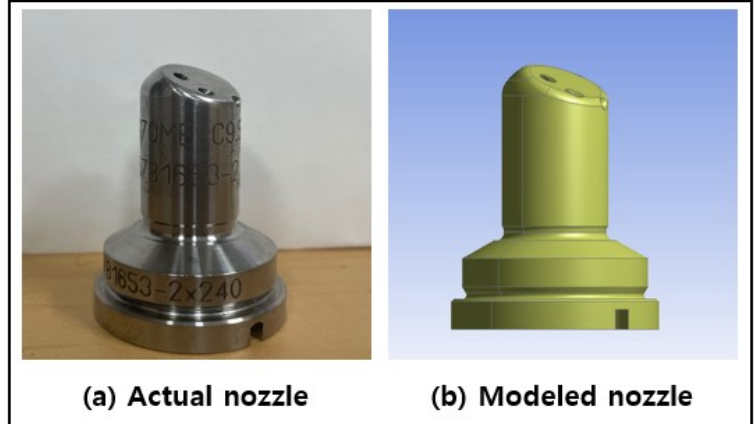
Figure 2. Gas-injection nozzle of a DF engine.